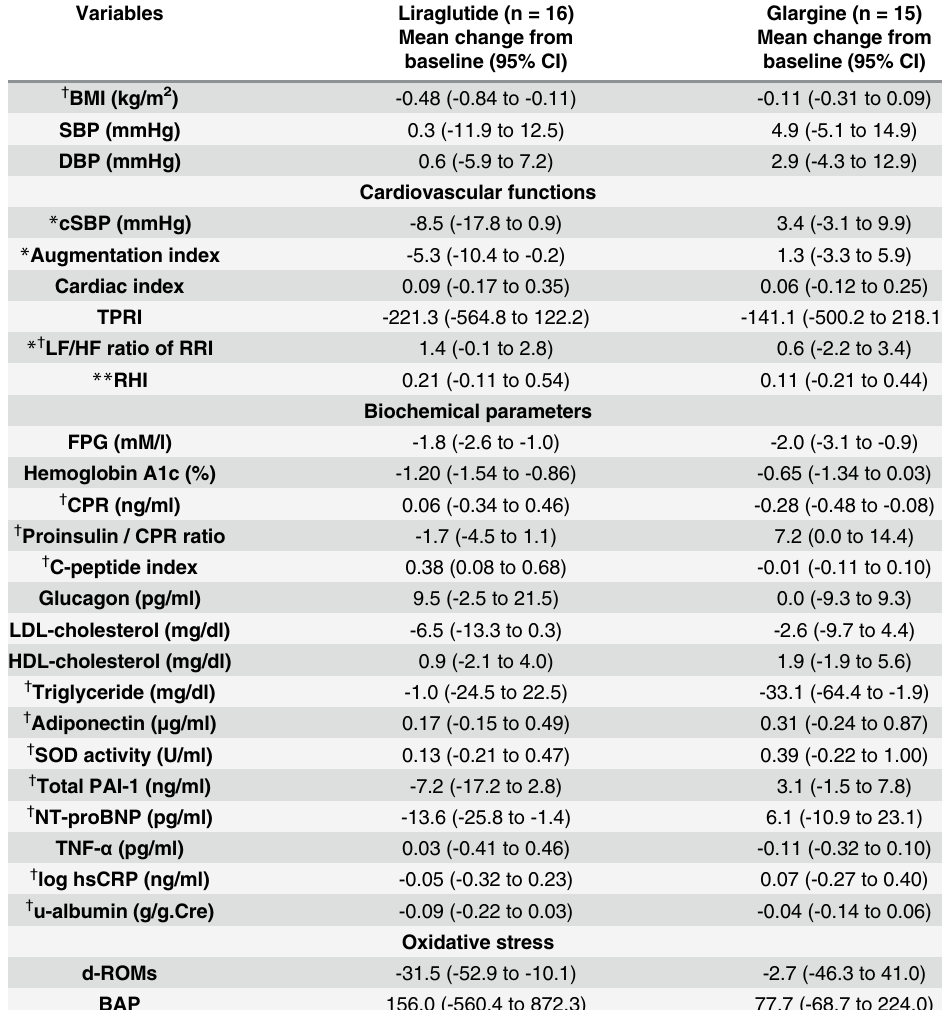
Table 3. Comparison of the effects on endothelial function and clinical and biochemical parameters between liraglutide and